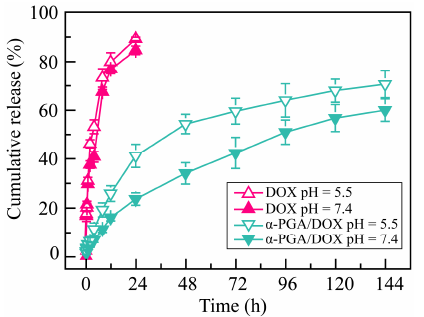
8 of 15 Figure 3. Particle size of α-PGA/DOX NPs in deionized water placed at 4 °C for 30 days ( a ); stability of α-PGA/DOX NPs in 5% glucose solution and plasma ( b ) ( n = 3).